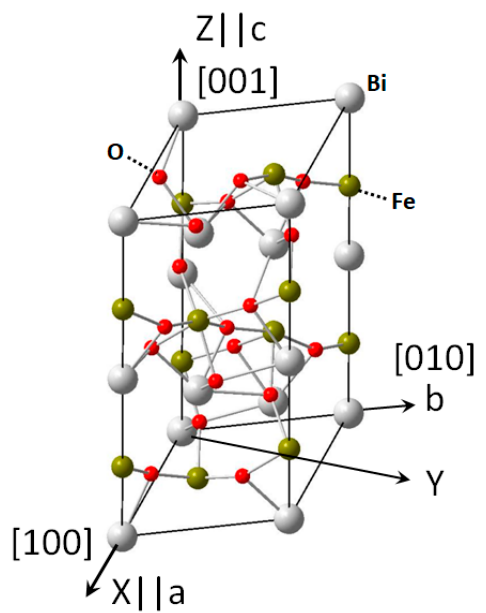
Figure 1. Illustration of the crystal structure of BiFeO 3 ( R3C space group, 3m point group). Lattice constants: a = b = 0.56 nm, c = 1.395 nm; α = β = 90°, γ = 120°. The chosen crystallographic coordinate system: X || a , Z || c , Y ⊥ a . The angle between Y and b ‐ axis is 30°.